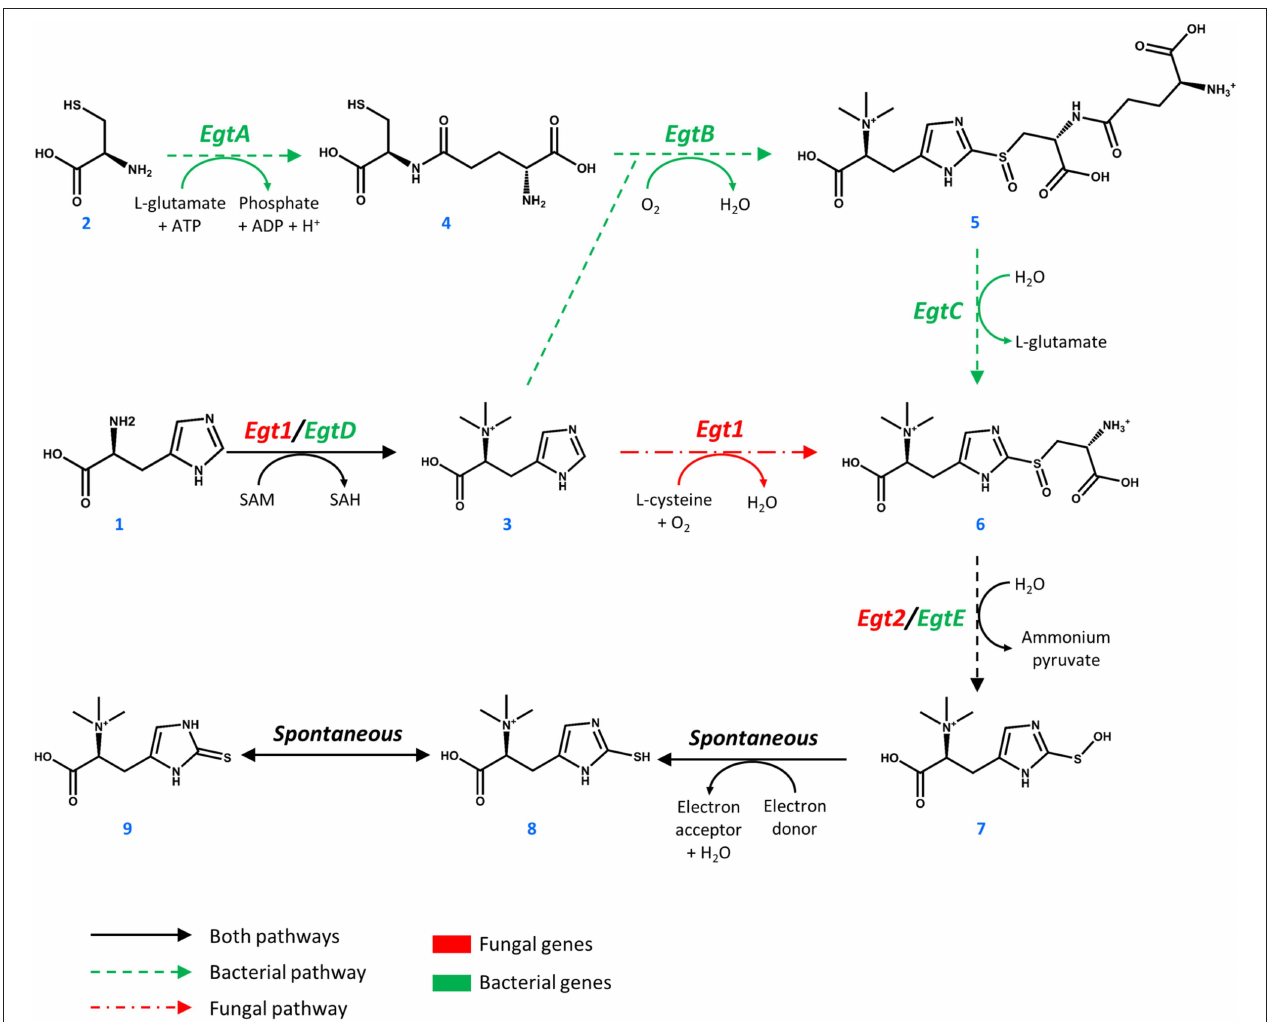
FIGURE 1 | Pathways toward ergothioneine biosynthesis in bacteria and fungi.